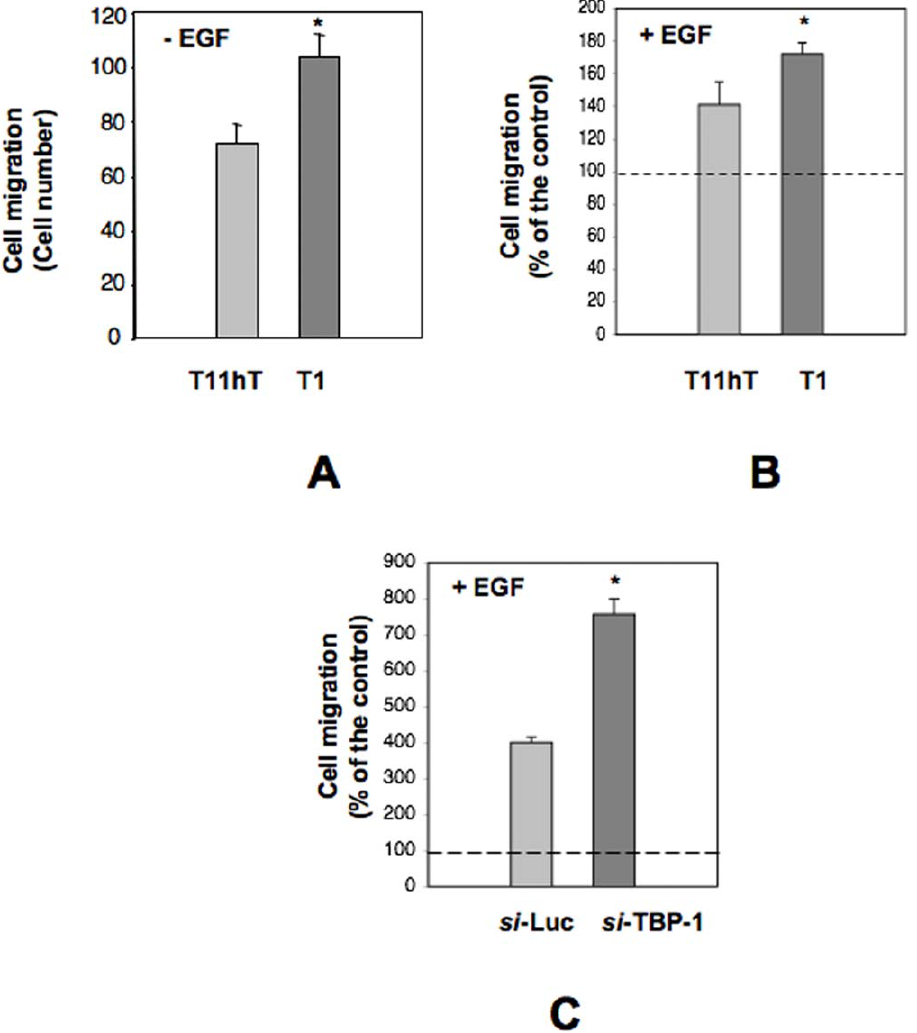
Figure 4. Silencing of TBP-1 determines an increase of the invading capability. A: Cells from the T1 clone or control cells (wt T11hT) were plated in Boyden chambers and allowed to migrate on filters coated with Matrigel. The values are the mean 6 SE of three experiments performed in triplicate. (*) p=0.046 as determined by the Student’s t test. B: Cells from the T1 clone or control cells (wt T11hT) were plated in Boyden chambers and allowed to migrate toward EGF on Matrigel filters. 100% values represent cell migration in the absence of chemoattractants. The values are the mean 6 SE of three experiments performed in triplicate. (*) p=0.027 as determined by the Student’s t test. C: Cells transiently transfected with TBP1 si -RNA or with the control si-RNA ( si -Luc) were plated in Boyden chambers and allowed to migrate toward EGF on filters coated with Matrigel. 100% values represent cell migration in the absence of chemoattractants. The values are the mean 6 SE of three experiments performed in triplicate. (*) p=0.016 as determined by the Student’s t